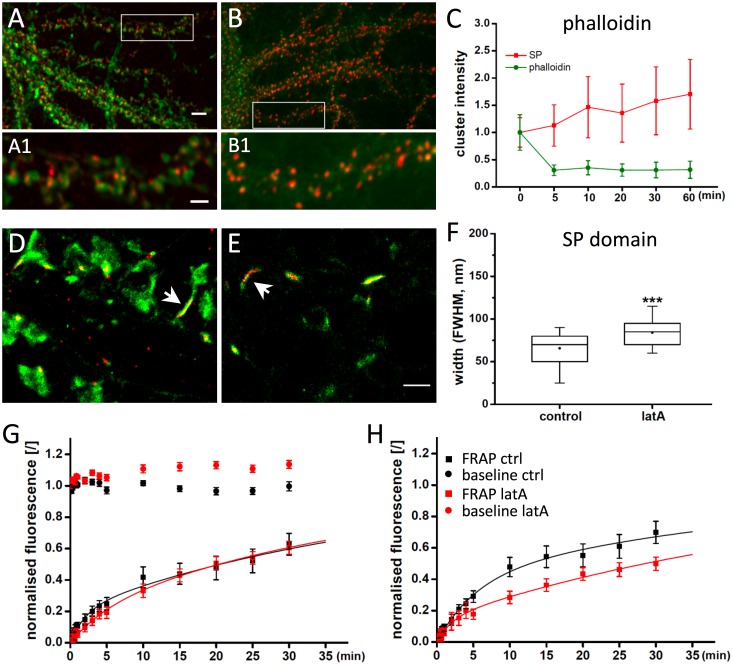
Effect of actin depolymerisation on SP distribution.(A,B) Endogenous SP (red) and A647-phalloidin (green) labelling in control neurons (A) and after 5 min incubation with 5 μM latrunculin A (B). (C) Quantification of the total phalloidin and SP fluorescence intensity in SP clusters at different time points of latA application (n ≥ 100 cells, 3 cultures, normalised mean fluorescence ± SD). All time points were significantly different from the baseline value (phalloidin: p < 0.001 for all time points versus time zero; SP: p < 0.05 at 5 min and p < 0.001 for 10–60 min versus time zero, ANOVA). (D,E) Super-resolution imaging of lentivirus-expressed dendra-SP (red) and A647-phalloidin (green) in spines in control conditions (D) and after 5 minutes latA treatment (E). (F) Quantification of the FWHM of SP domains in spine necks in control and after latA treatment (5 μM, 5 min). Actin depolymerisation induced a significant expansion of the SP domain (p < 0.001, MW, nctr = 34, nlat = 33; Table C in S1 File). (G) Time-lapse imaging of mRFP-SP clusters in transfected neurons confirms the increase of cluster sizes during latA treatment (red circles) compared to control (black circles; mean ± SEM; p < 0.001 for the 15–30 min time points between the two conditions, ANOVA). FRAP recovery rates in absolute terms are not different between control (black squares) and latA (red squares; p = 0.7 for the pooled data from 10–30 min, MW). (H) Normalisation of the FRAP data to their respective baseline disclosed a reduced exchange rate during latA application (p = 0.001 for the pooled data from 10–30 min between the two conditions, MW). Scale bars: 5 μm in A, 2 μm in A1, 1 μm in D,E.